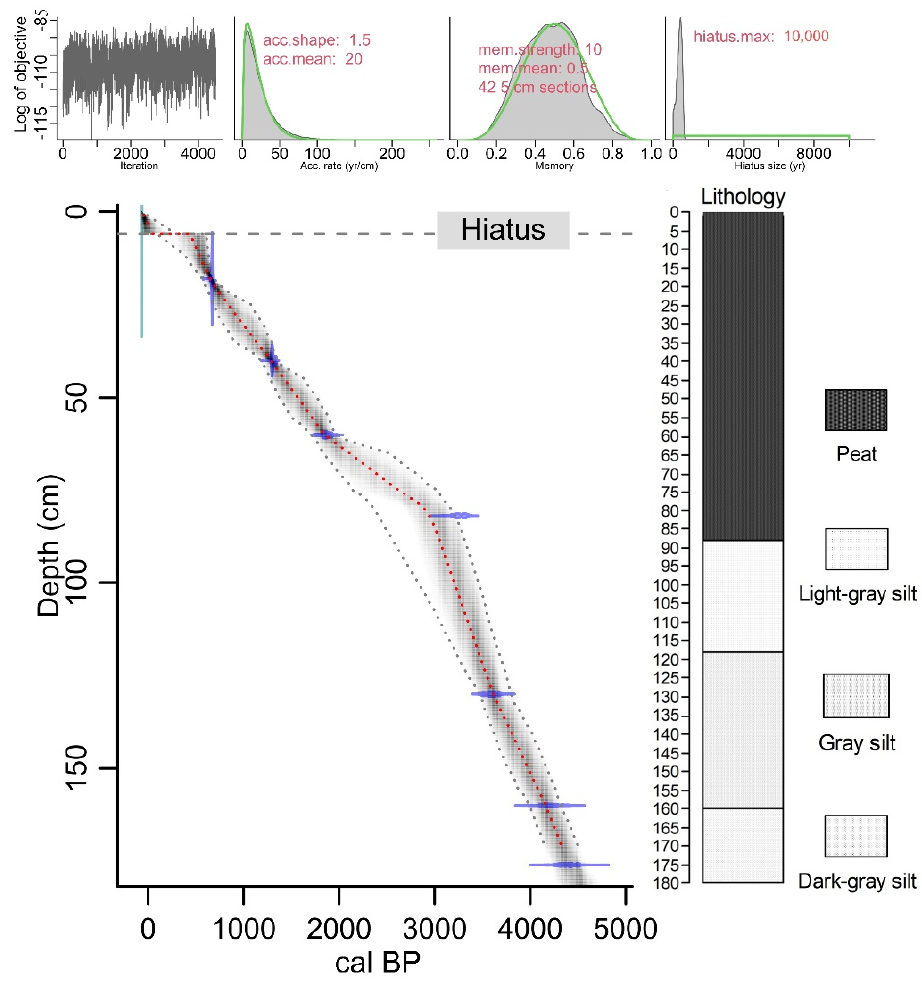
Figure 4. Age–depth model and lithology for Dream Lake generated using Bayesian analysis in package “rbacon” for R [12]. The gray shading indicates the 95% probability intervals for the age models. Seven radiocarbon dates (blue) were used for calibration. The hiatus was set at a depth of 6 cm. Table 1. Radiocarbon dates estimated for Dream Lake sediments. Calibrated radiocarbon ages with 2 σ error were computed using Calib 8.20 (http://calib.org/calib/calib.html, accessed on 1 July 2021), which uses the IntCal20 calibration curve